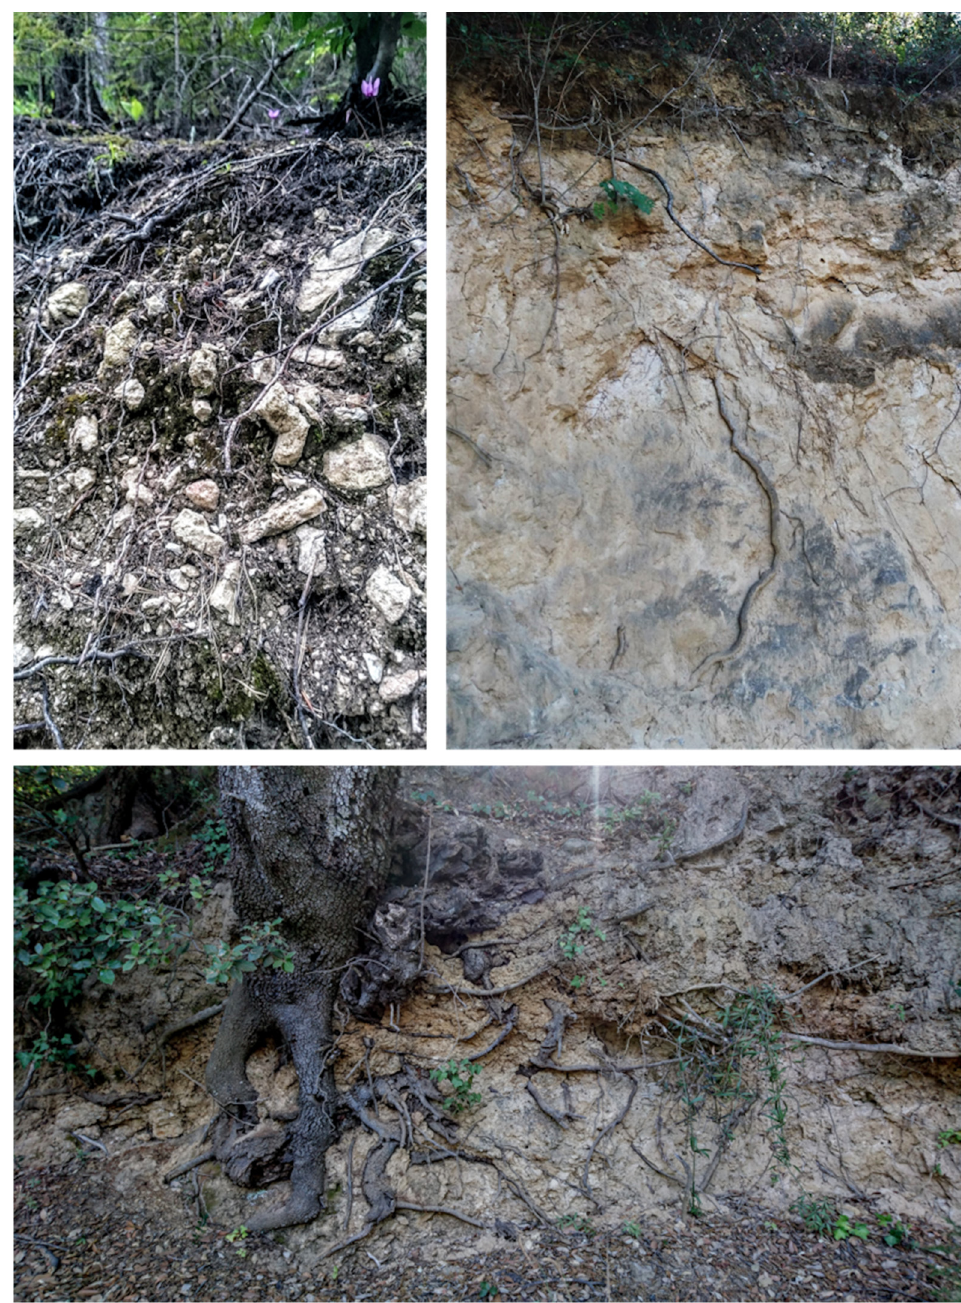
Figure 2. Interactions of small and large roots with soil particles and rocks that generate the root reinforcement